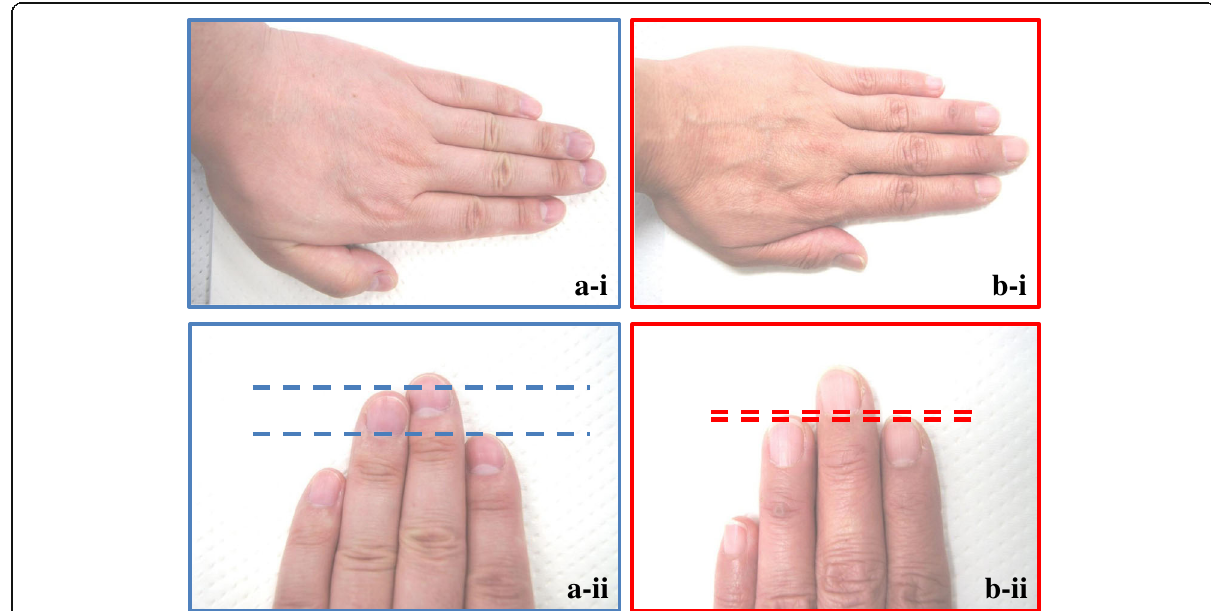
Fig. 3 Relationship between the difference in ring and index finger lengths and the sex of the individual. a - i and a - ii : The figures show the length of the finger of the male. b - i and b - ii : The figures show the length of the finger of the female